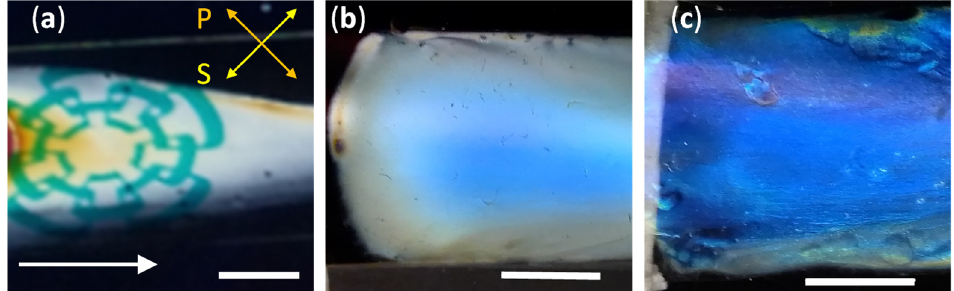
Figure 5. ( a ) Photograph of a film deposited the same day the CNC suspension was prepared, placed at an angle of 45° between a source of linear polarization (S direction) and a crossed polarizer (P direction); the white arrow shows the direction of applied shear. ( b , c ) show images of films prepared from non-sonicated suspension stored for 18 and 38 days, respectively. Scale bars are 1 cm.